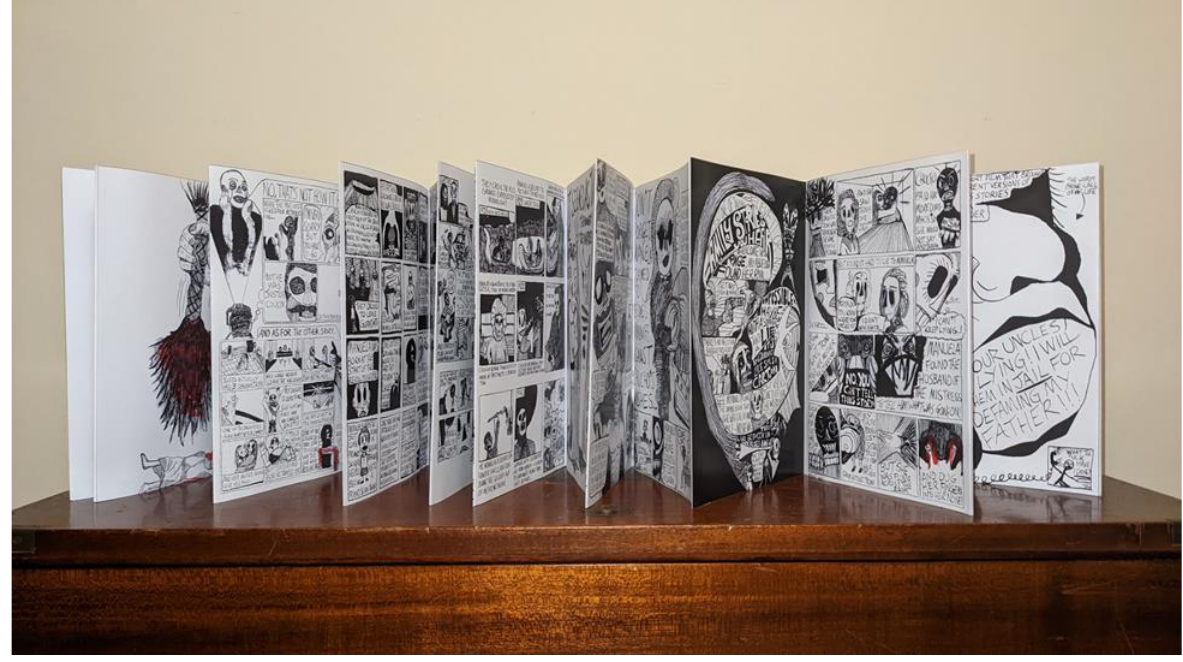
Figure 12: An extended copy of Breaking Tezcatlipoca (2019) With regards to the formulation of the comic book, the concertina format (see Figure 12) was selected because of the way the graphic ethnography book changes the relationship of the reader with the object and therefore how the comic is read. Having previously experimented with the concertina book as object-mem ory for a family photo album about my mother’s perspective on my great - grandparent’s stories (Sherwood Gonzalez 2019b), the specific formulation for Breaking Tezcatlipoca serves to highlight the ephemerality not only of the object through the lightness of the paper but also of the phenomena of memory and forgetting. Furthermore, this is evocative of the formulation of the Aztec codices like the Codex Borgia that was actually read from right to